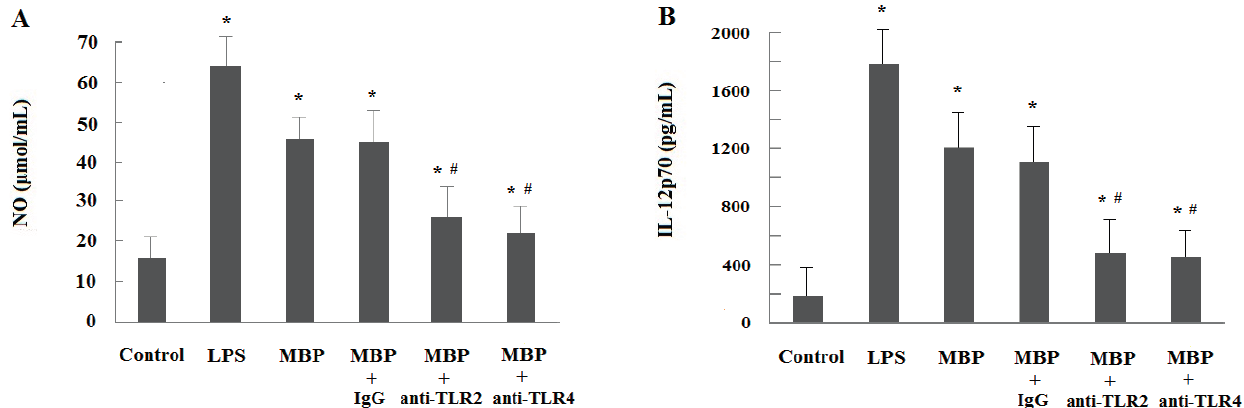
Figure 6. Effects of MBP-induced activation and polarization of RAW264.7 cells via TLR2 and TLR4. RAW264.7 cells were pre-incubated with anti-TLR2 or